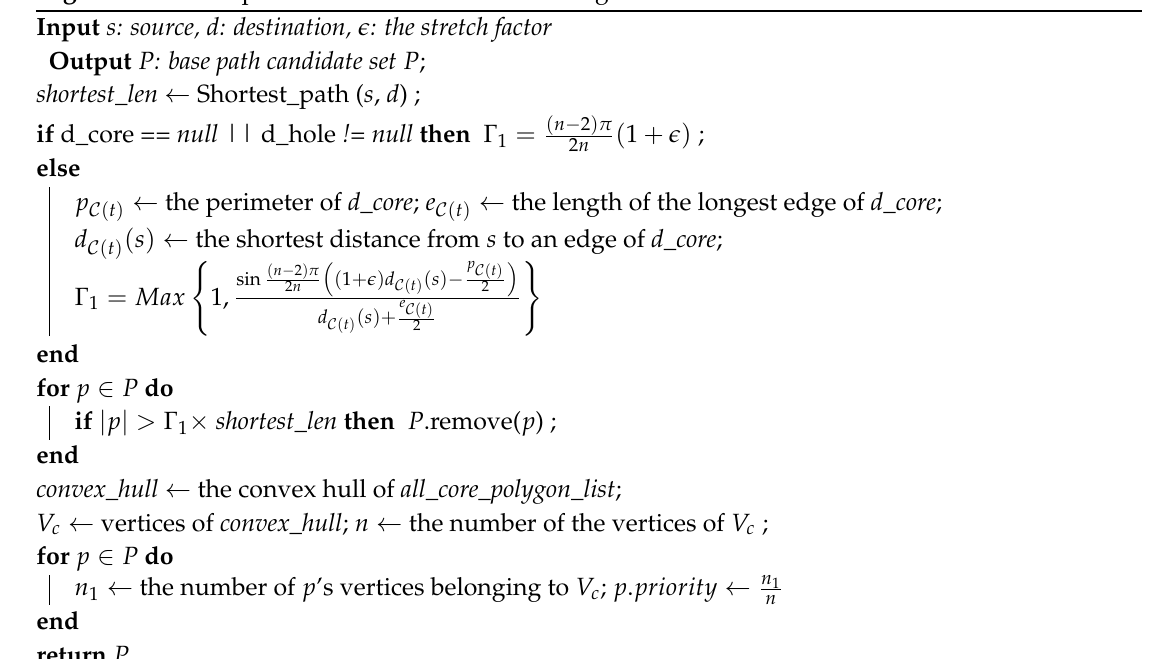
Algorithm 1: Base path candidate determination